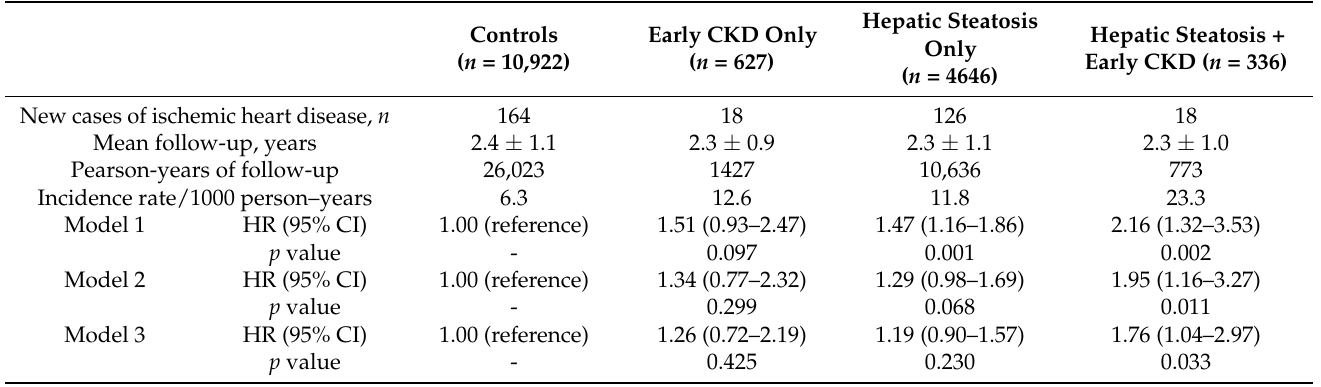
Table 2. Hazard ratios and 95% confidence intervals for new-onset ischemic heart